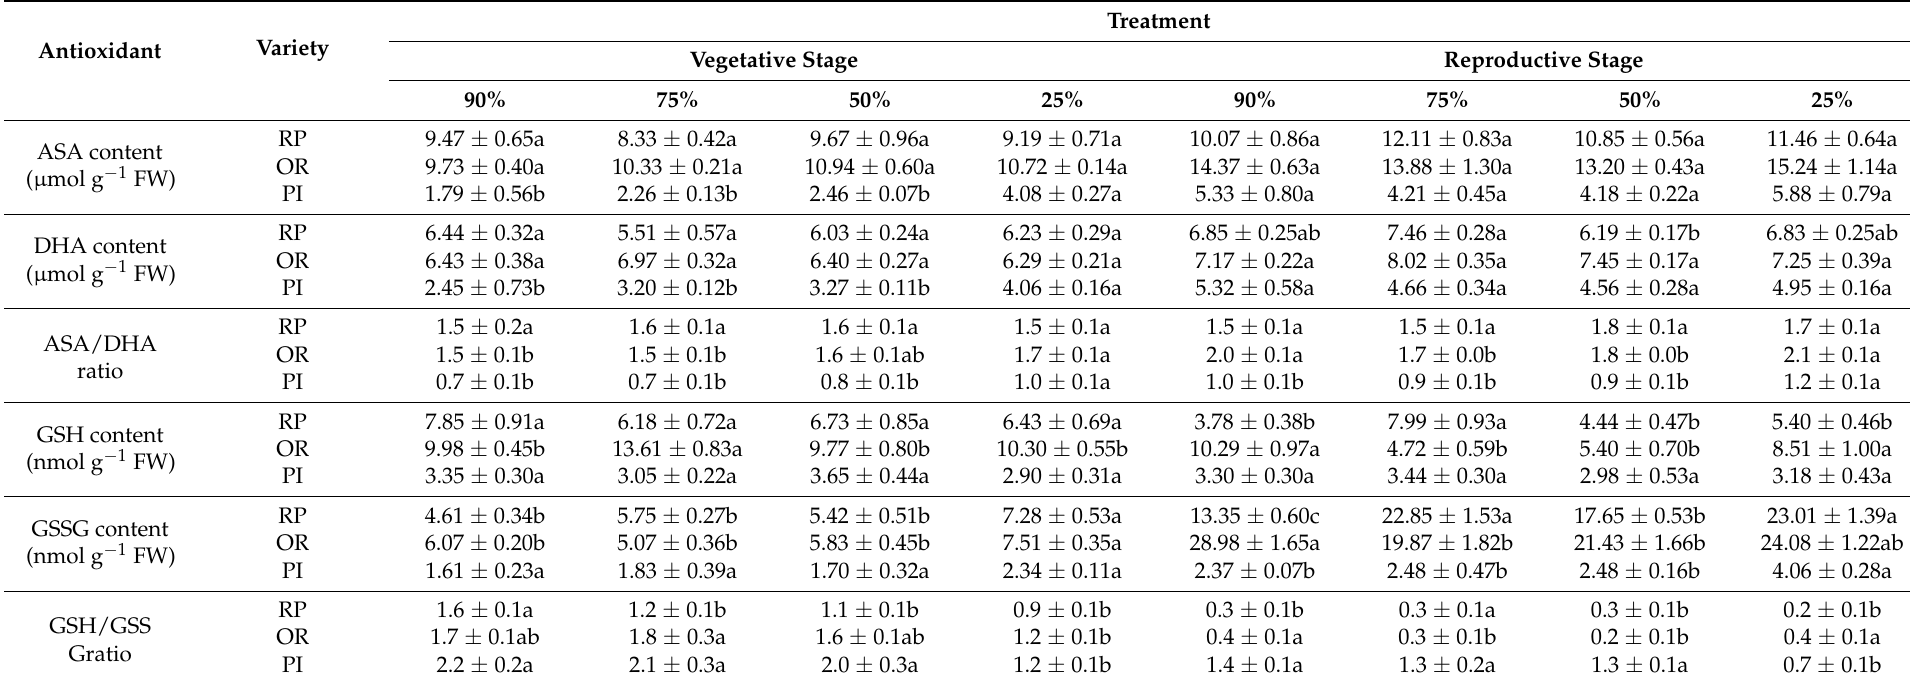
Table 2. Effect of drought stress on antioxidant content in C. formosana and C. quinoa